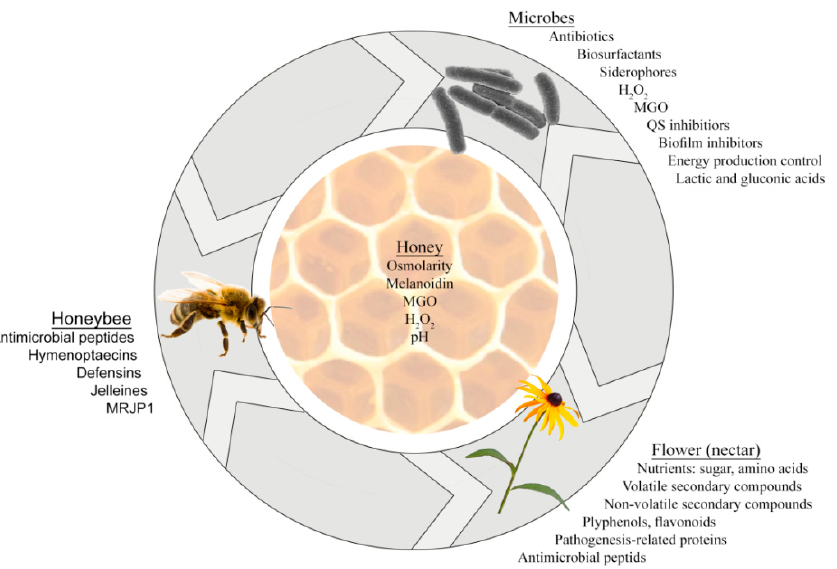
Figure 1. Three-way interactions between microbes, plants and honey bees during which the secondary metabolites are produced and contribute to honey antimicrobial activity.